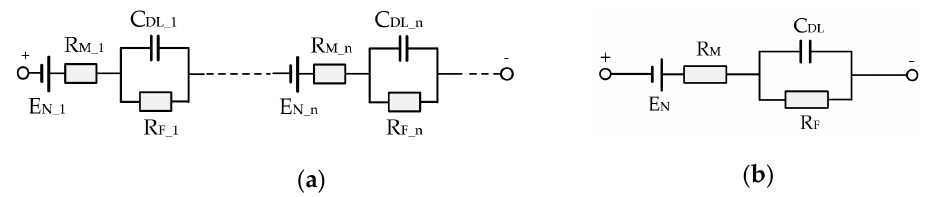
Figure 4. Randle’s equivalent circuit model : ( a ) Presented by individual parameter of each fuel cell; ( b ) presented by consolidated parameter of each fuel cell.